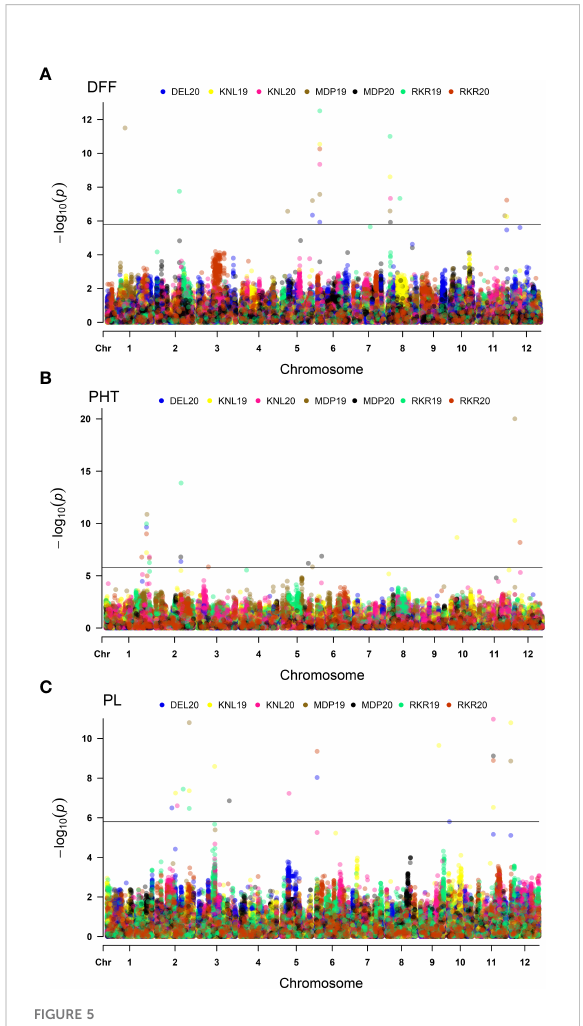
FIGURE 5 Multi-Environmental Manhattan plots depicting signi fi cant MTAs for various agronomic traits viz ., Days to fi fty percent fl owering (DFF) (A) , Plant height (PHT) (B) and Panicle length (PL) (C) . The dots marked in different colours indicate QTNs detected in different environments. The horizontal line indicates Bonferoni